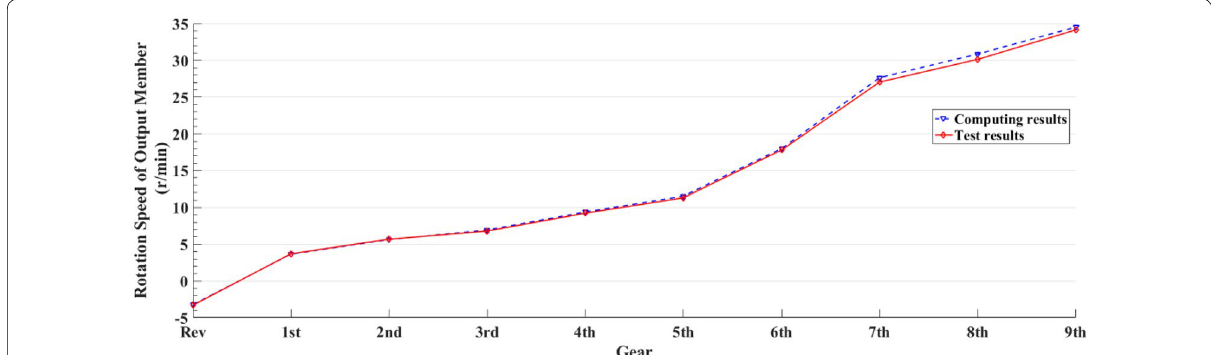
Figure 23 Comparative analysis of computing results and test results for the rotational speed of the output